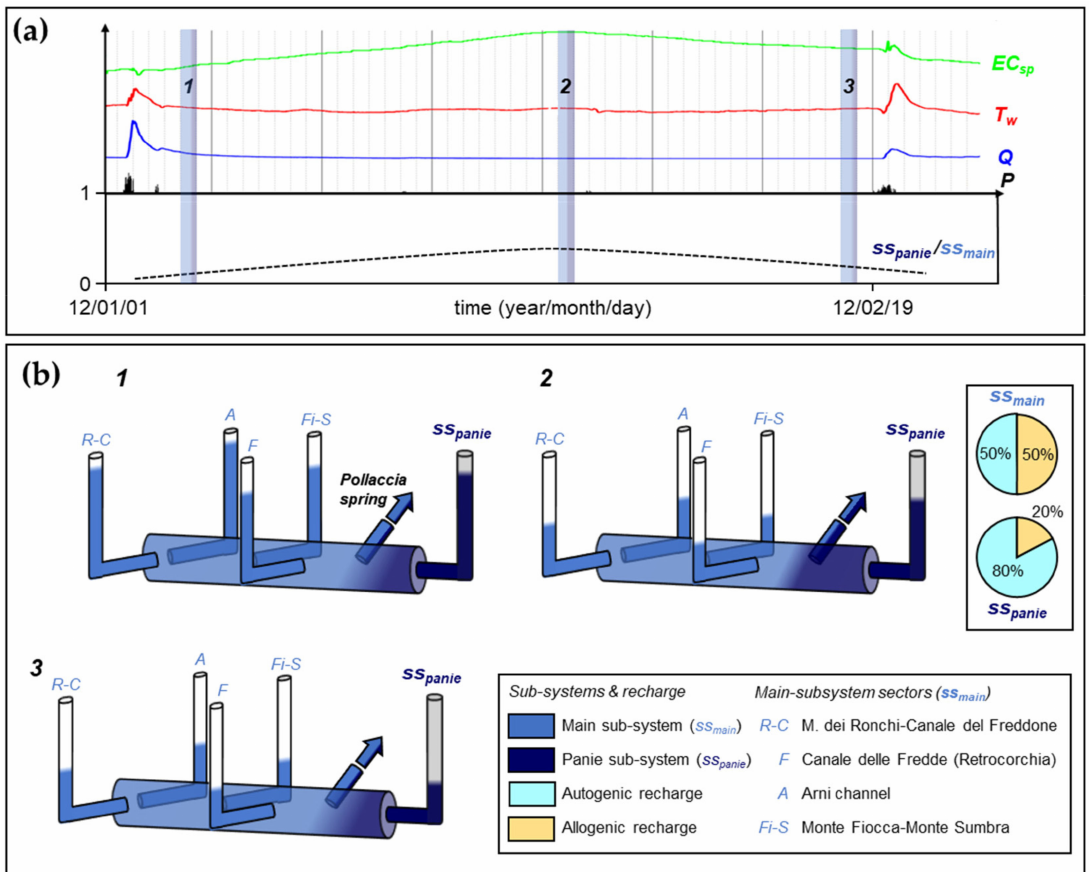
Figure 9. ( a ) Water discharge Q , T w , and EC sp graphs and a ratio expressing the relative contribution to spring discharge of the two sub-systems from 1 January 2012 to 26 February 2012, showing a period with no significant precipitation events; ( b ) groundwater flow models during steps 1, 2, and 3 depending on the proportions of allogenic/autogenic recharge for the two